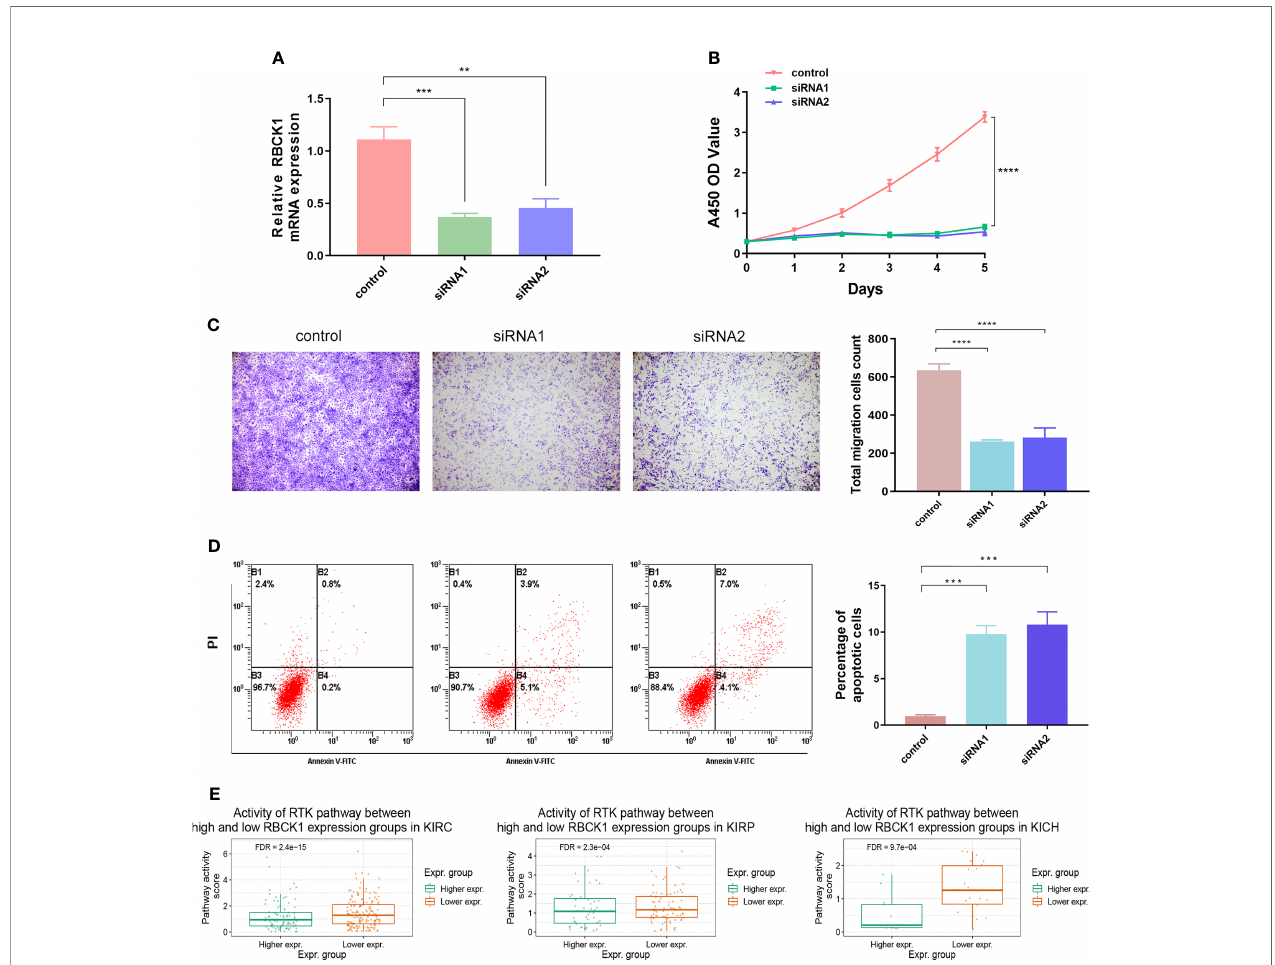
FIGURE 10 | Inhibition of RBCK1 attenuates cell proliferation and migration and promotes cell apoptosis abilities of 786-O cell. (A) SiRNA was used to knock down the expression of RBCK1 in the human ccRCC cell line, 786-O. (B, C) The CCK-8 and Transwell assays were detected after the siRNAs were transfected in human ccRCC cells. (D) Early and late apoptotic cell proportions using the FITC/PI kit. Cell populations with FITC − /PI − , FITC+/PI − , FITC+/PI+, and FITC − /PI+ were regarded as living, early apoptotic, late apoptotic, and necrotic cells, respectively. (E) Differential RBCK1 inactivation level in the score of receptor tyrosine kinase (RTK) pathway in RCC samples from TCGA (** p < 0.01, *** p < 0.001, **** p <